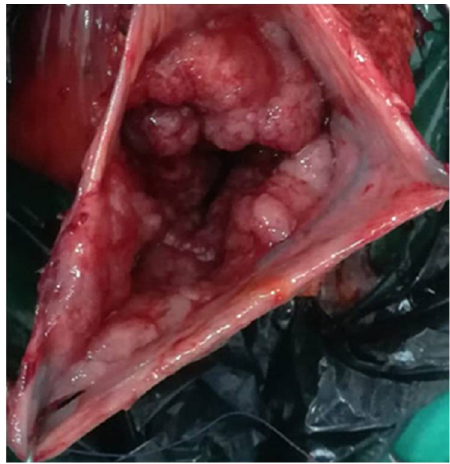
Figure 4. Resected specimen.